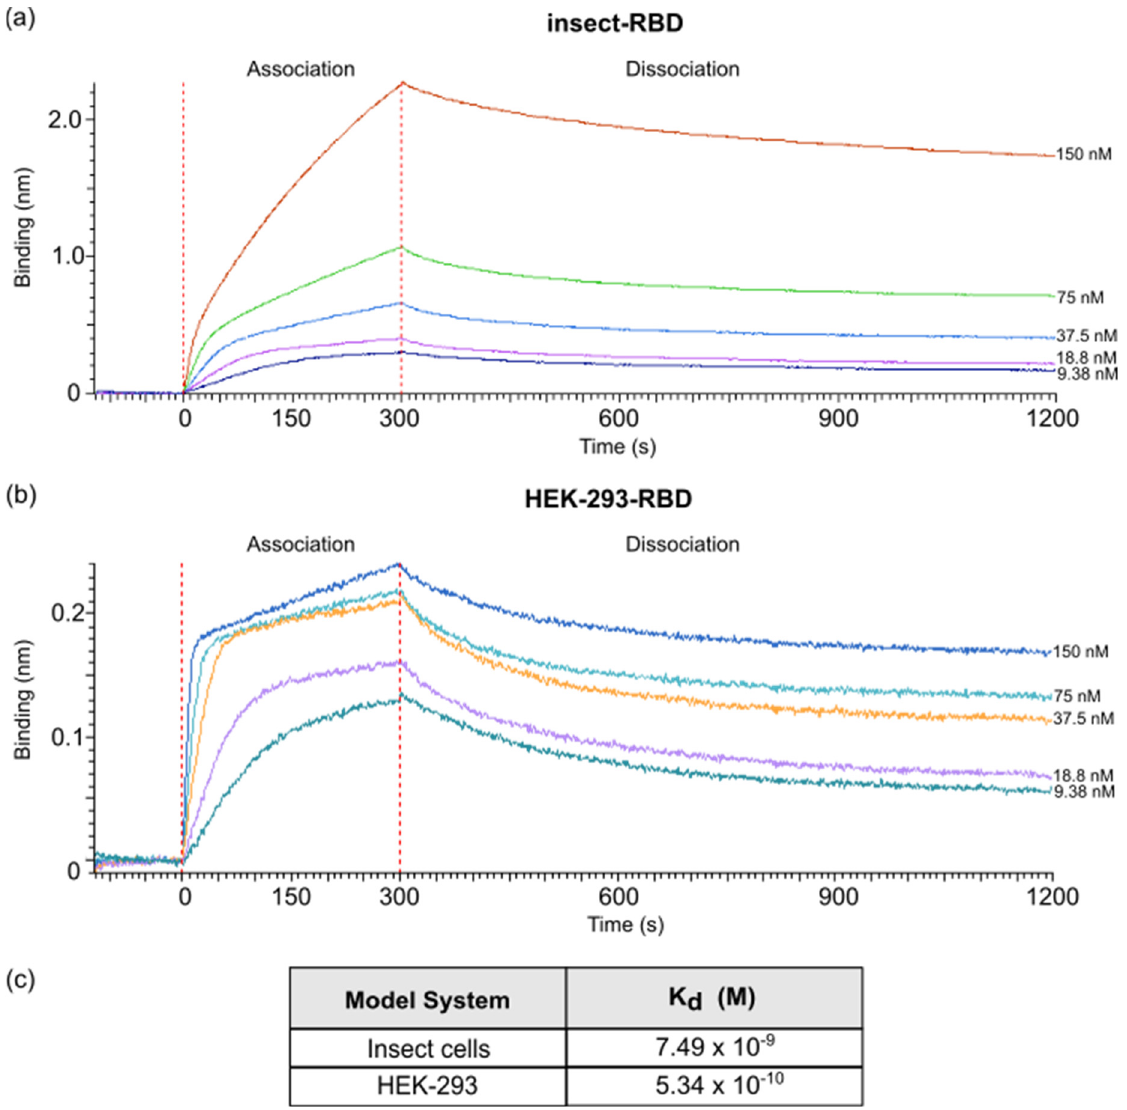
Figure 5. BLI measurements. ( a ) BLI profiles accounting for the binding of insect-RBD and ( b ) HEK-293-RBD to ACE2-hFc. After a baseline, the sensorgram starts with the association (0–300 s) of the RBD to the ACE2-loaded sensor, followed by the dissociation phase (900 s). ( c ) K d measured values.